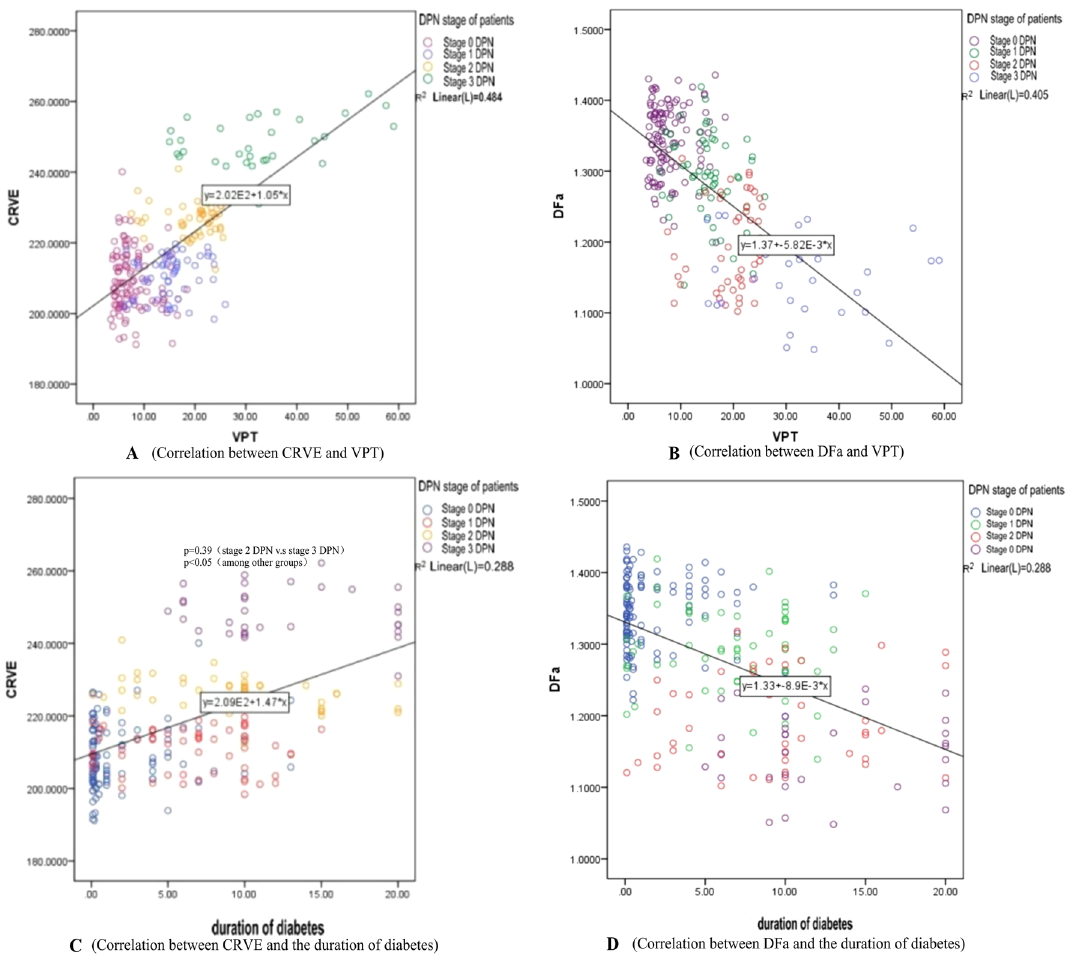
Figure 2. Correlation of CRVE, DFa, and VPT with duration of diabetes. CRVE Central retinal vein equivalent, DFa Fractal dimension arterioles, VPT Vibration perception